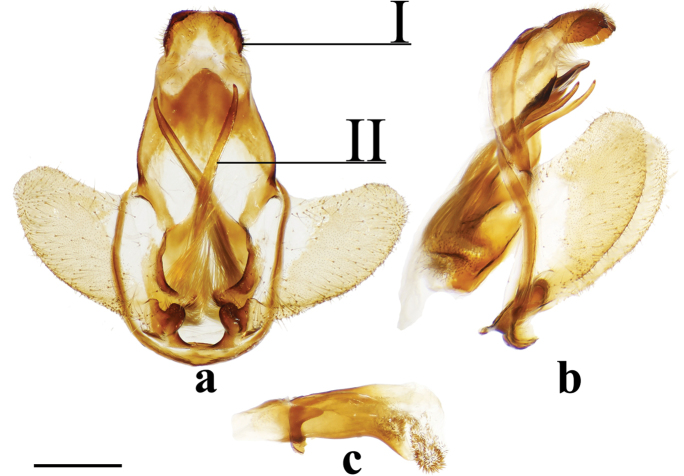
Male genitalia of Fatellallafatellaa ventral b lateral c phallus. Roman numerals refer to characters discussed in the text. Ecuador, Napo, Yasuni, St Laurent diss.: 10-26-17:1 (CPL). Scale bar: 1 mm.